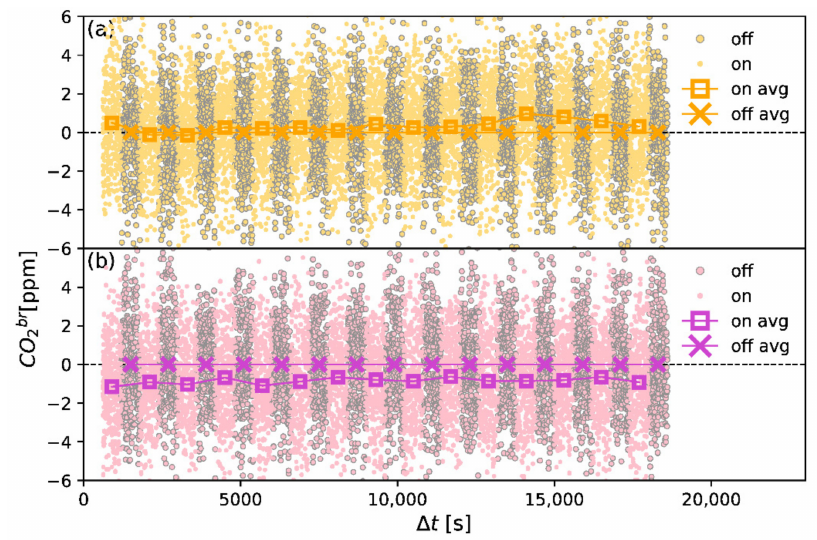
Figure 5. For clarity, we present time series of CO 2 br (background trend removed with moving average window of 1200 s) of 15 test iterations to exemplify CO 2 concentration anomalous biases relative to the background. Whereas brighter and darker dots represent soundings recorded when the blower was switched on and off, the square and cross markers are averages of each of the segments. Therefore, the differences between averages represent the outcomes of test airflow blowing at chambered ( a ) and chamber-less setups ( b